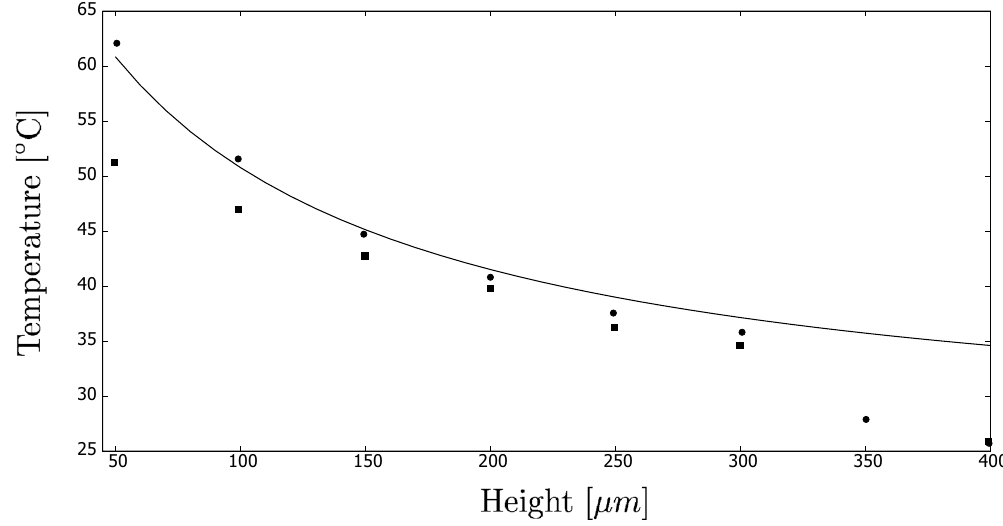
Figure 13. Theoretical analysis of a DASC (solid line) compared with 26 (boxes and circles). The literature results focus on two different scenarios that were not modelled by